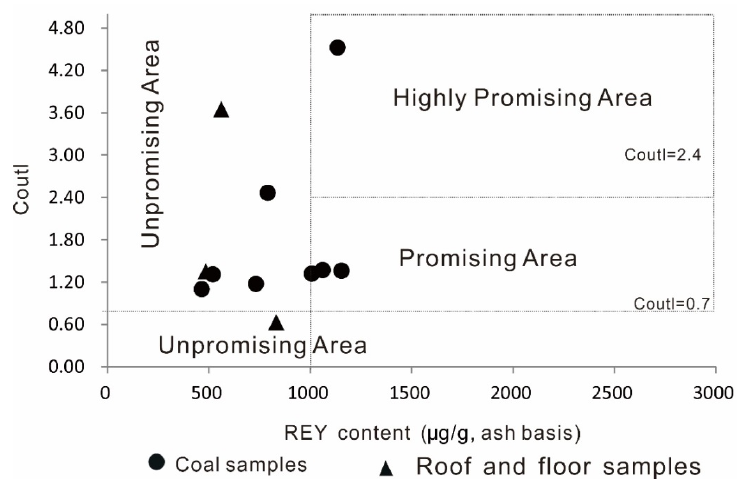
4 of 18 Figure 11. SEM back-scattering images of zircon in sample PSDZ-2 from the Donggou mine ( A ) and the energy dispersive spectrum data of spot 1 ( B ). 4.6. Prelimiary Economic Evaluation of REY and Li Seredin and Dai (2012) proposed the cut-off grade of REY in the coal ash (REO in coal ash is 1000  g/g) [6]. In addition, in order to further evaluate the economic significance of REY, a three-fold classification was used based on the REY supply and demand relationships [6]. REY were divided into critical (including Nd, Eu, Tb, Dy, Y, and Er), uncritical (including La, Sm, Pr, and Gd), and excessive (including Ce, Ho, Tm, Yb, and Lu) groups [6,69]. An index called outlook coefficient (C outl ) was defined as the ratio of the proportion of critical REY in total REY to the proportion of excessive REY in total REY [6]. The C outl >1 represents REY in coal ash being highly promising, 0.7 < C outl < 1.9 represents it as promising, while C outl < 0.7 is unpromising [70]. According to the classifications based on Dai et al. (2017) [70], a graph of C outl -REY was plotted (Figure 12). It can be seen that there is one coal sample (PSDZ-9) located in the highly promising area, and three coal samples (PSDZ-5, PSDZ-6, and PSDZ-7) located in the promising area. As mentioned above, the average concentration of REY oxides in the Donggou coal ashes is 1026  g/g, higher than the cut-off